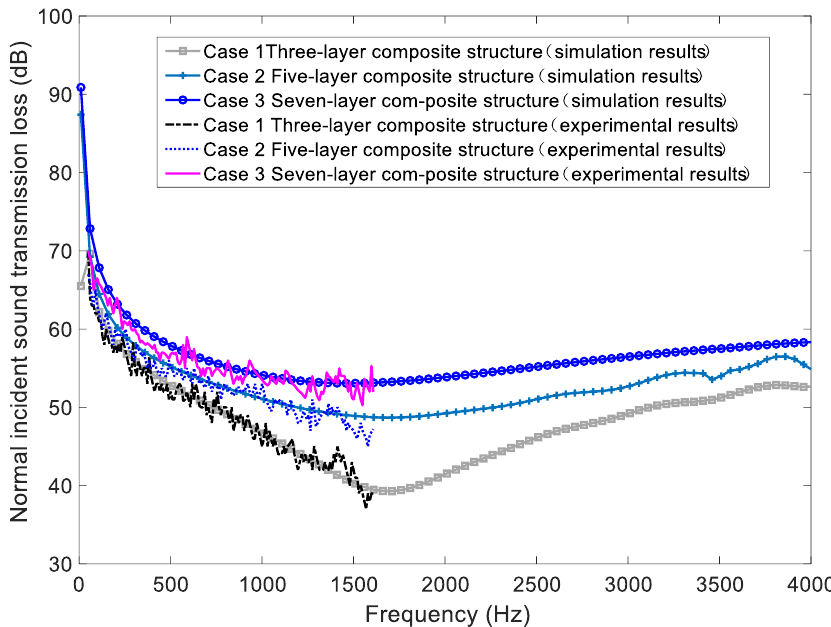
Figure 10. Comparison of simulation and experimental results; STL trends represent the simulation and experimental results of Case 1, Case 2, Case 3.